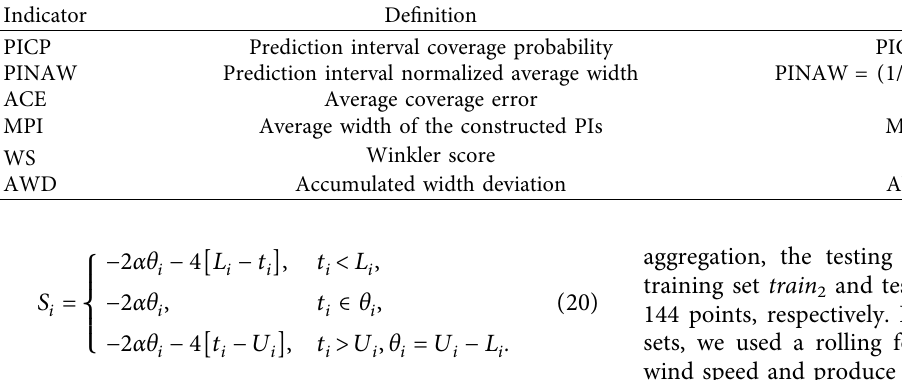
Table 3: Six interval prediction evaluation